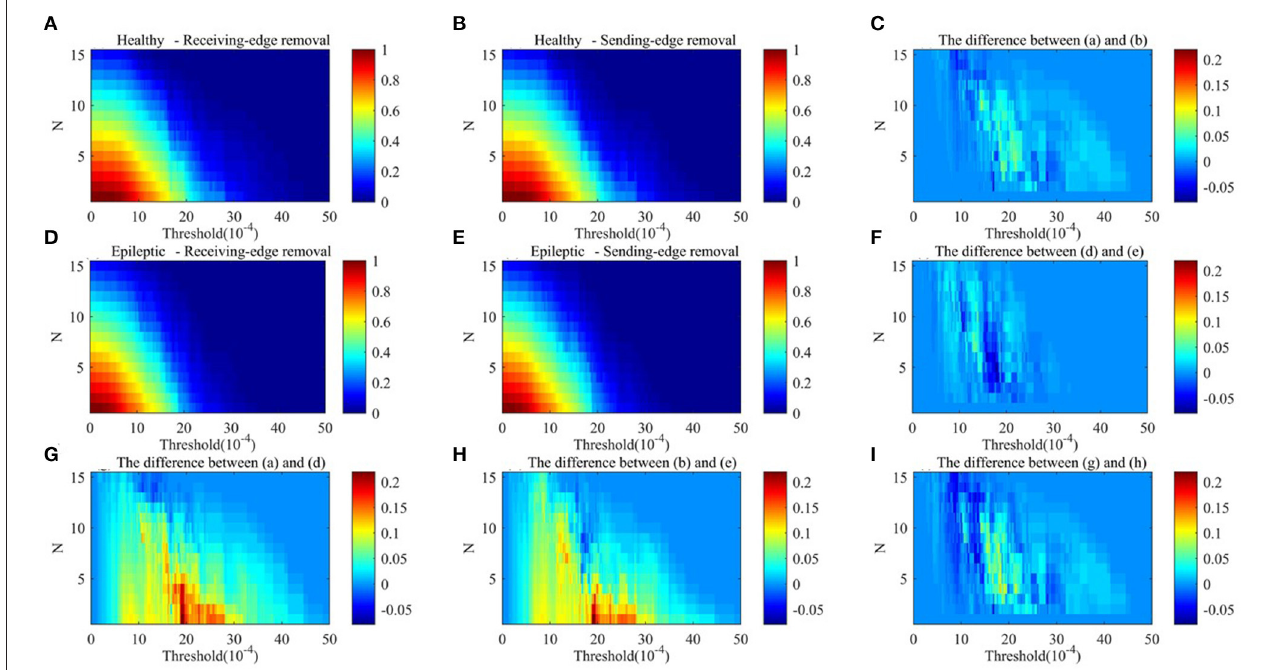
FIGURE 10 | The network efficiency values of residual networks in alpha rhythm. (A) Healthy sample brain networks based on receiving-edge removal. (B) Healthy sample brain networks based on sending-edge removal. (C) The difference between (A) and (B) . (D) Epileptic sample brain networks based on receiving-edge removal. (E) Epileptic sample brain networks based on sending-edge removal. (F) The difference between (D) and (E) . (G) The difference between (A) and (D) . (H) The difference between (B) and (E) . (I) The difference between (C) and (F) .